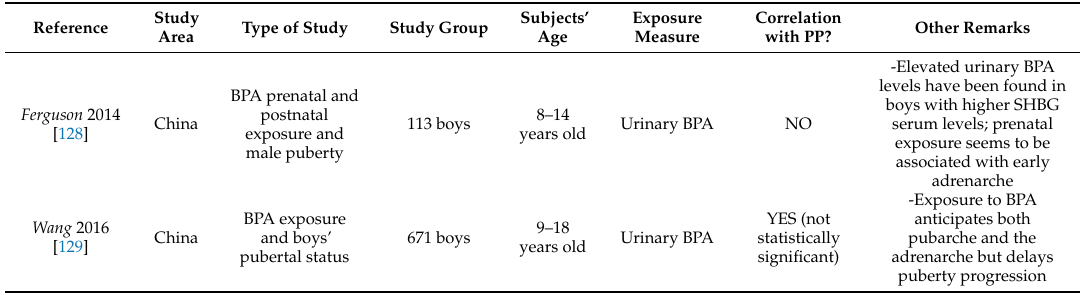
Table 3. Overview of epidemiological studies investigating the relationship between bisphenol A (BPA) and male precocious